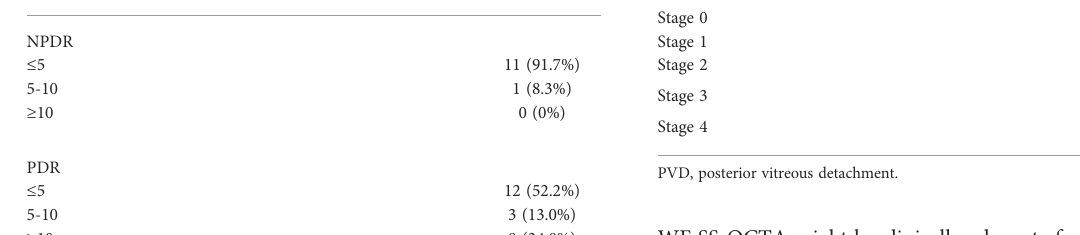
TABLE 2 NPAs measured by UWFFA out of the area of the panoramic OCTA image. Features (NPAs/DA)